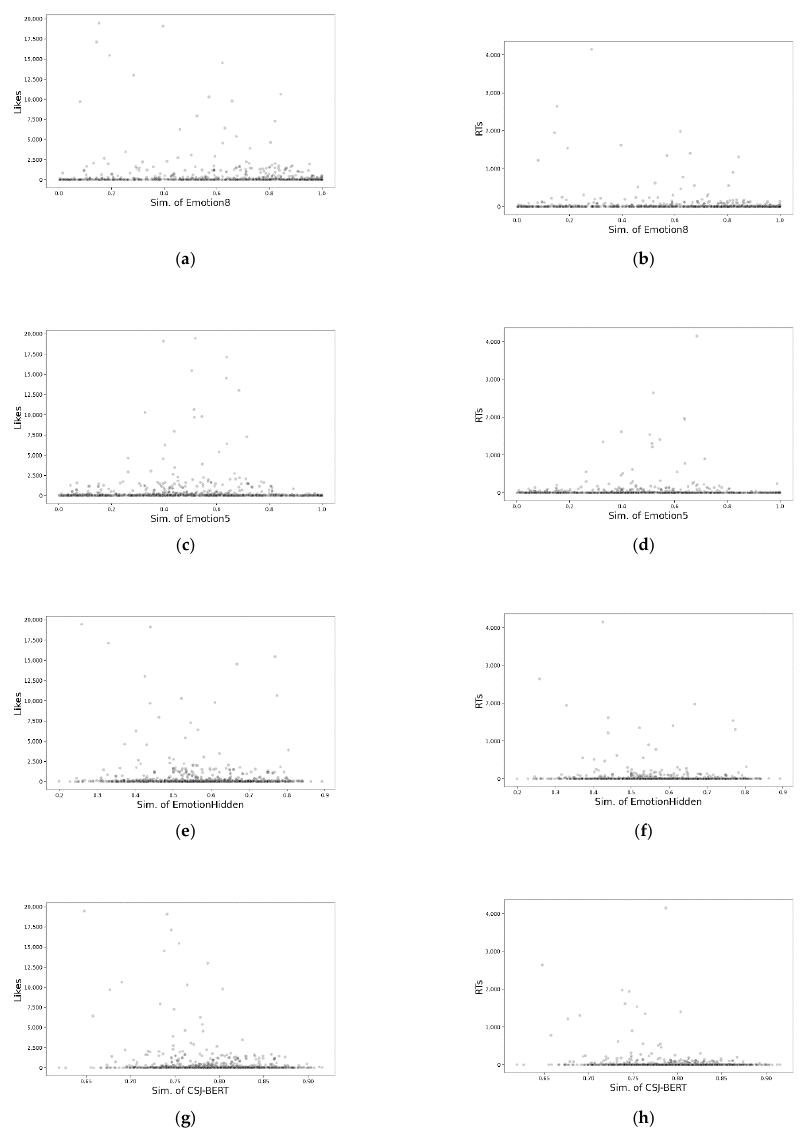
Figure 4. Relation between like/RT and feature vectors of tweets and replies. ( a ) Relation of sim tw8,rp8 and like, ( b ) Relation of sim tw8,rp8, RT, ( c ) Relation of sim tw5,rp5, like, ( d ) Relation of sim tw5,rp5, RT, ( e ) Relation of sim twh,rph, like, ( f ) Relation of sim twh,rph, RT , like, ( g ) Relation of sim twb,rpb, like, ( h ) Relation of sim twb,rpb,